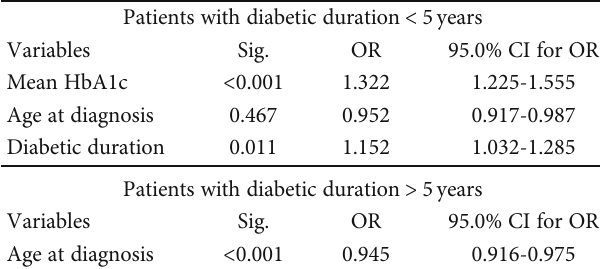
Table 2: Factors associated with β -cell function by COX regression